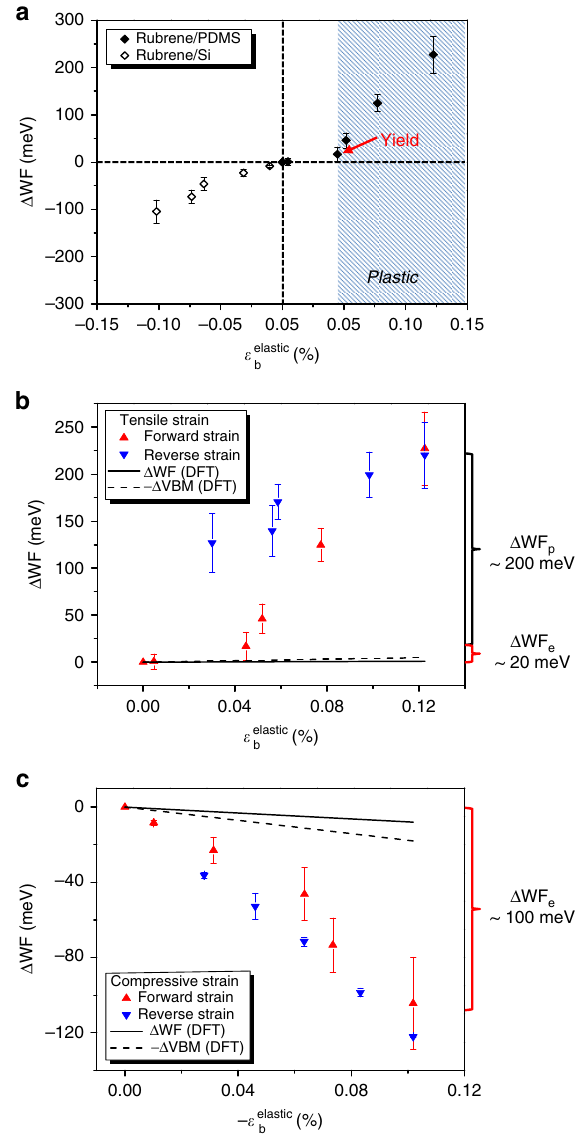
Figure 5 | D WF as a function of substrate-induced elastic strain. ( a ) D WF as a function of e elastic (tensile and compressive strain) along the b axis. The WF increases with tensile strain and decreases with compressive strain. Note that D WF in the shaded region is mainly a result of plastic deformation instead of elastic tensile strain. ( b ) D WF as a function of elastic tensile strain for forward and reverse strains. There is an elastic-to-plastic transition characterized by a sudden rise in D WF with strain. There is a large hysteresis of D WF between the forward and reverse tensile strains, indicating the effect of plastic deformation. The DFT calculation results are shown by the dashed line ( (cid:2) D VBM) and the solid line ( D WF). The calculated (cid:2) D VBM and D WF slightly increase with elastic tensile strain, a trend that qualitatively agrees with the experimental results. The quantitative disagreement between the calculations and the experimental results in the high-strain regime is attributed to plastic deformation, which is not considered in the calculations. ( c ) D WF as a function of elastic compressive strain for forward and reverse strains. The WF decreases with strain smoothly and no apparent elastic-to-plastic transition is observed. There is negligible hysteresis of D WF between the forward and reverse strains. The DFT calculation results are shown by the dashed line ( (cid:2) D VBM) and the solid line ( D WF). The calculated (cid:2) D VBM and D WF decrease with elastic compressive strain, a trend that qualitatively agrees with the experimental results. The deviation in the D WF magnitude of the calculations from the experiments may be due to dynamic effects that are not considered in the theoretical approach. The errors bars in D WF were based on standard deviation errors as described in Fig.